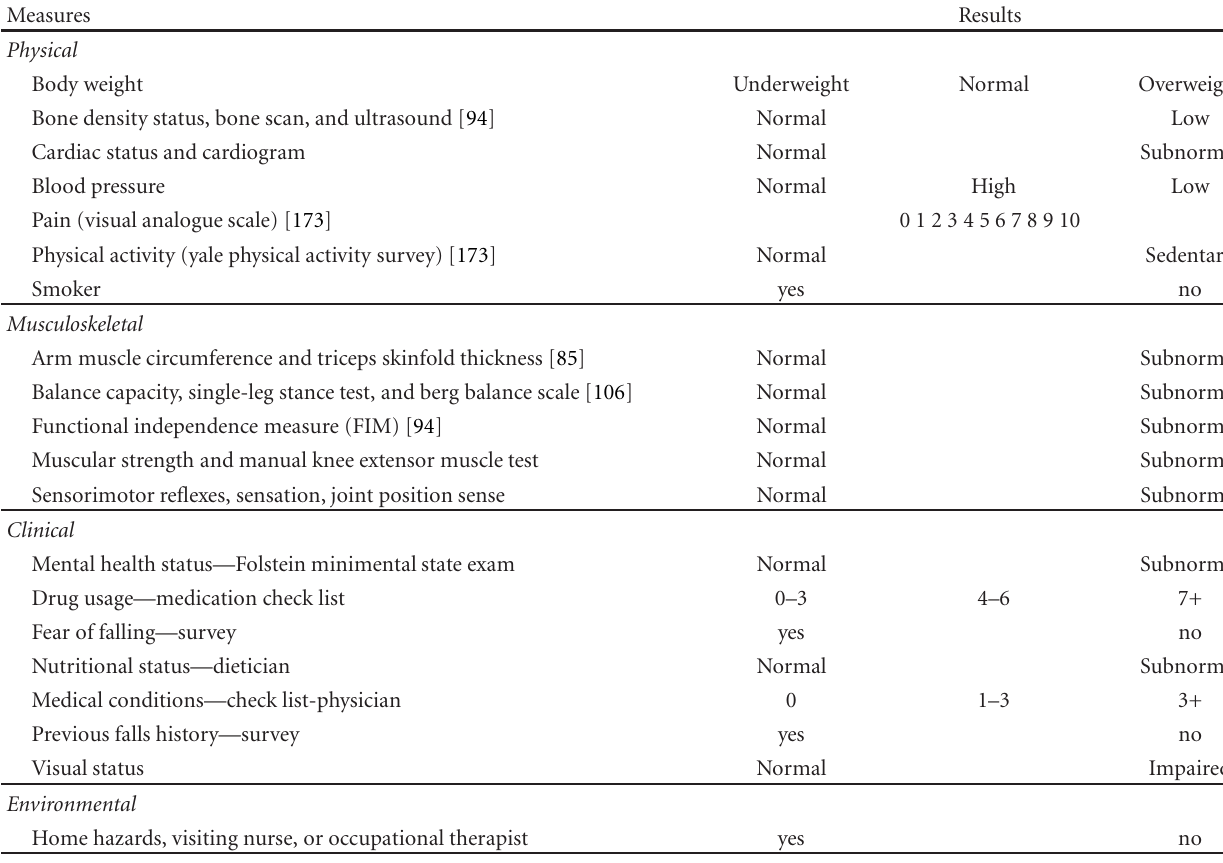
Table 5: Representative commonplace assessments and related checklist that could be used in primary care or community settings during regular examinations as well as among those receiving surgical interventions for a first hip fracture to identify those at high risk for first and secondary hip fractures and poor outcomes, as well as associated potential intervention